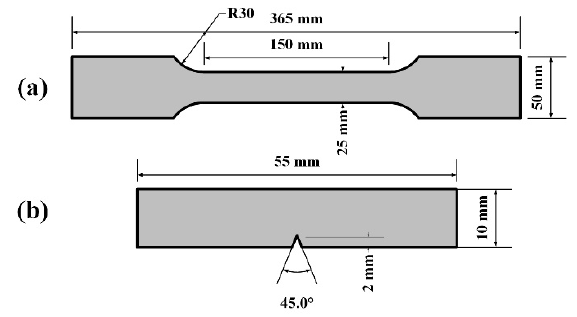
Figure 3. Size of ( a ) tensile test sample; ( b ) impact test sample.